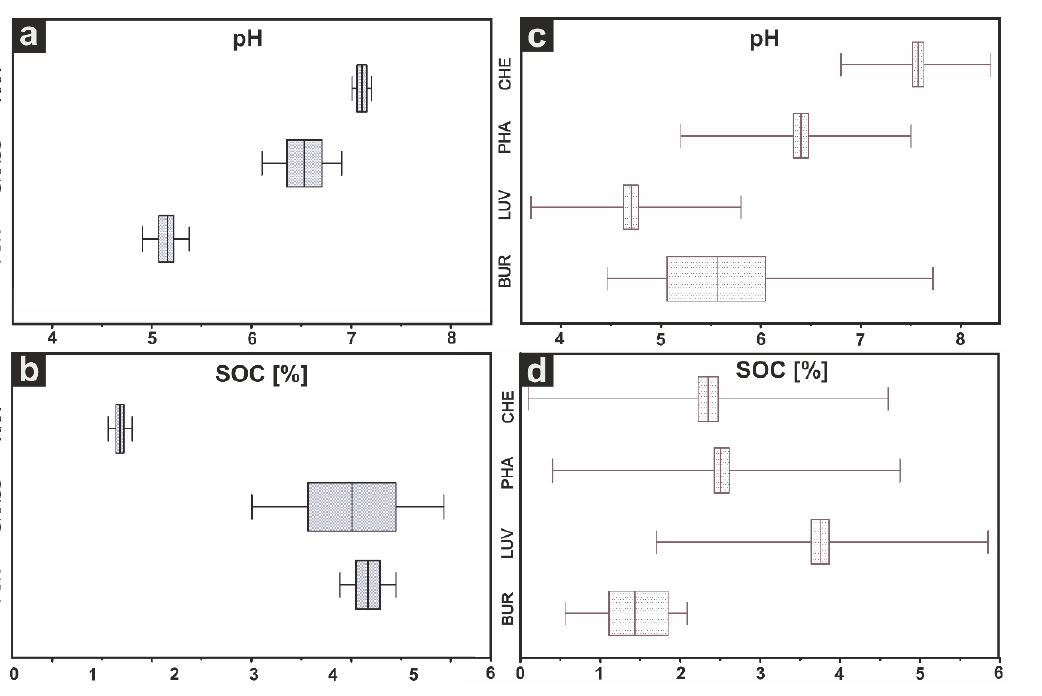
Figure 2. Basic properties of the soils under study sorted according to land use: ( a ) pH, ( b ) SOC, and soil type: ( c ) pH, ( d ) SOC. Boxes: standard error, central line: mean values, whiskers: standard de-